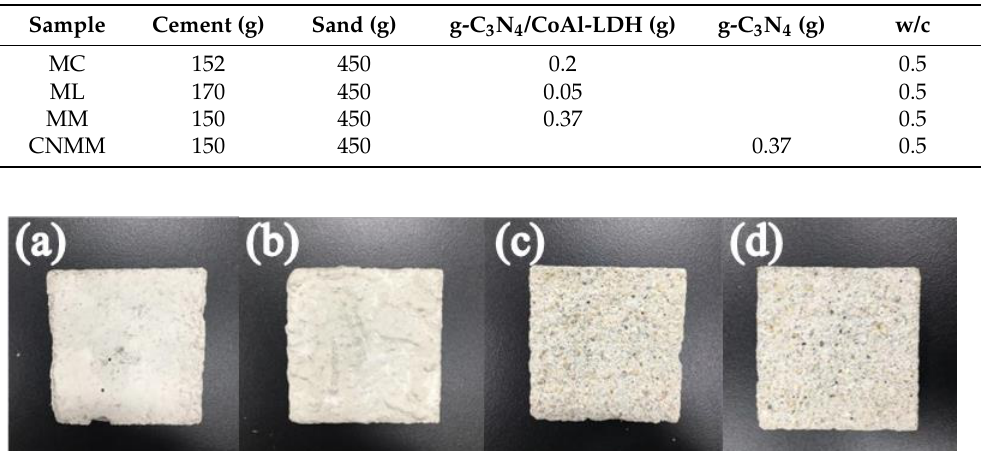
Table 4. Mix designs of the photocatalytic cement mortars.